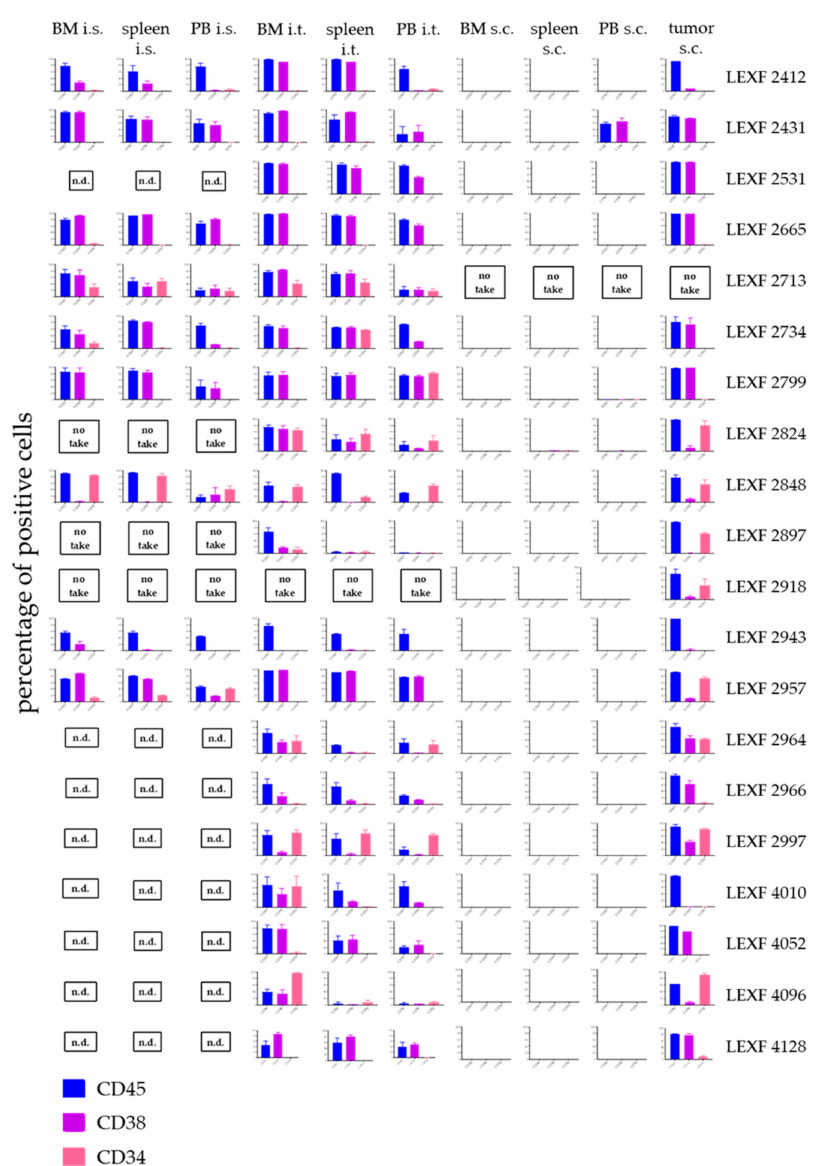
Figure 5. Infiltration pattern of 20 leukaemia PDX in bone marrow, spleen and peripheral blood depending on the injection site of the leukaemic cells. Each PDX model displayed its specific expression pattern of the three investigated surface markers CD45, CD38 and CD34 in all tested settings. Despite for one model, LEXF 2431, leukaemic cells did not infiltrate the haemopoietic organs when injected subcutaneously. A no take was defined by no growth after three individual experiments with n > 3 mice and an observation time > 2-fold of the passaging time of the individual model. n.d., not